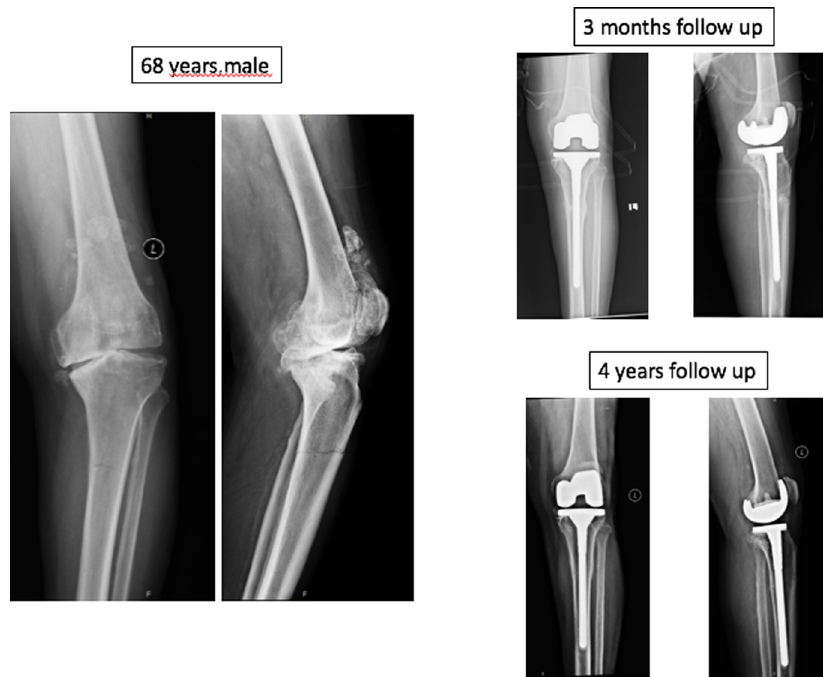
Figure 2. Acute stress fracture treated with long stem